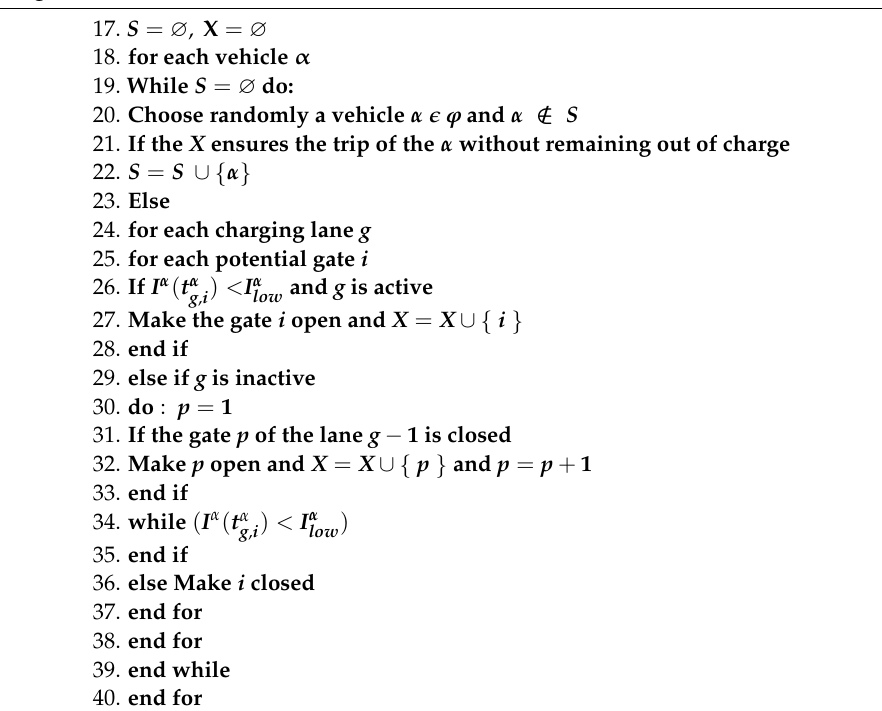
Algorithm 2: Generation of an individual